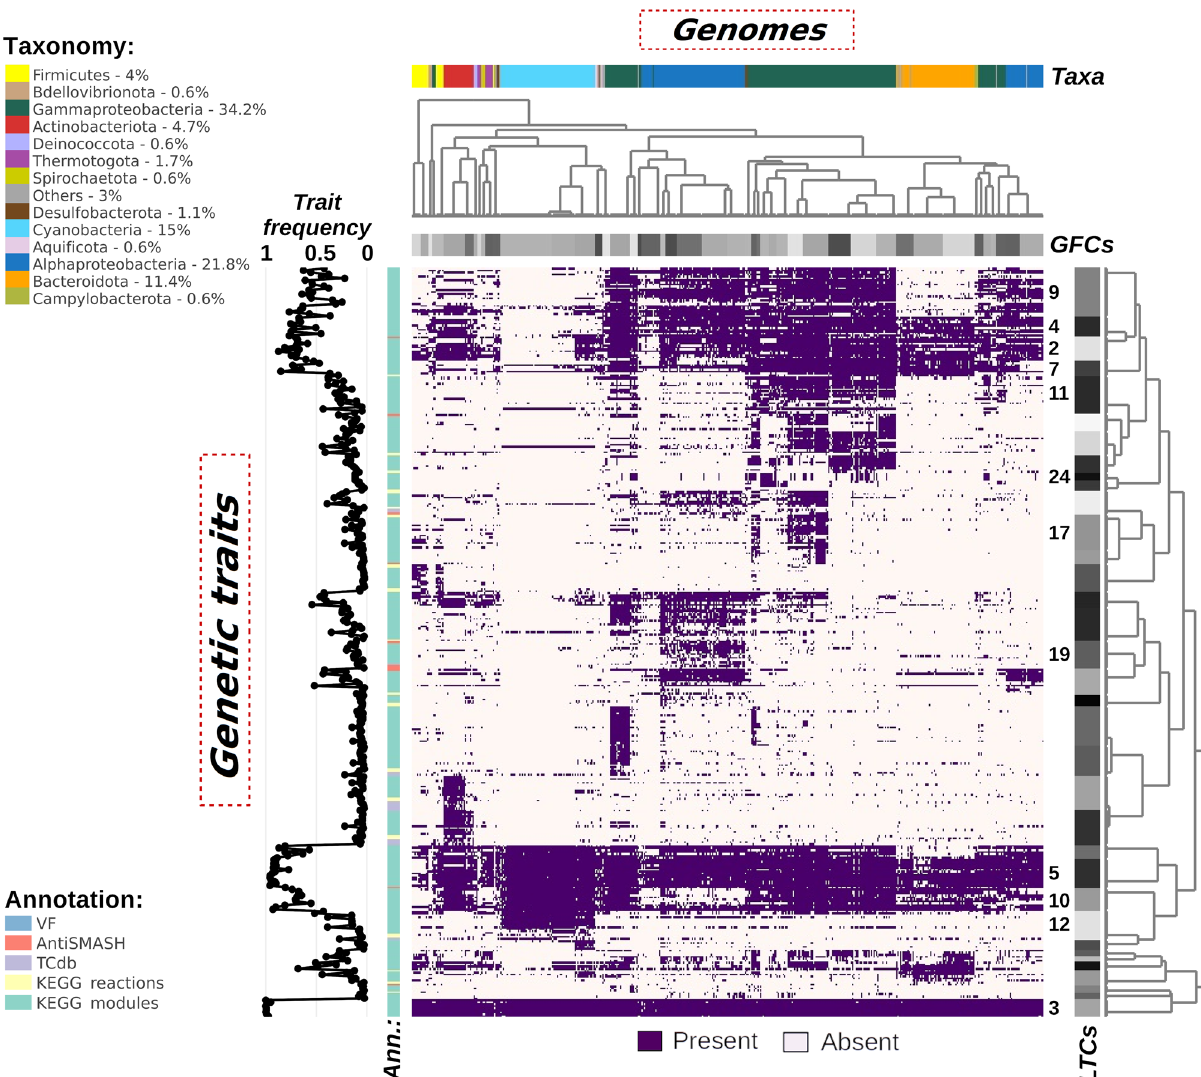
Fig. 1 Atlas of Marine Microbial Functional Traits showing patterns of genetic traits across all analysed genomes. Columns represent genomes grouped into genome functional clusters (GFCs) as shown by the horizontal grey bar. The horizontal colour bar represents the taxonomic af fi liation of genomes (mainly phyla, with the exception of Proteobacteria that are represented at the class level). The number next to each taxon in the legend represents the percent from the total genomes analysed. Rows represent the genetic traits grouped into linked trait clusters (LTCs) as shown by the vertical grey bar. LTCs discussed in the text are labelled with the related number alongside the grey bar. The vertical line plot shows the frequency of each genetic trait across all genomes and the vertical colour bar represents the annotation tool used to identify each trait. Both dendrograms are computed using the aggExCluster function (R package apcluster) that generates hierarchal clustering from an af fi nity propagation result. An interactive version of this fi gure is available at https://doi.org/10.6084/m9. fi